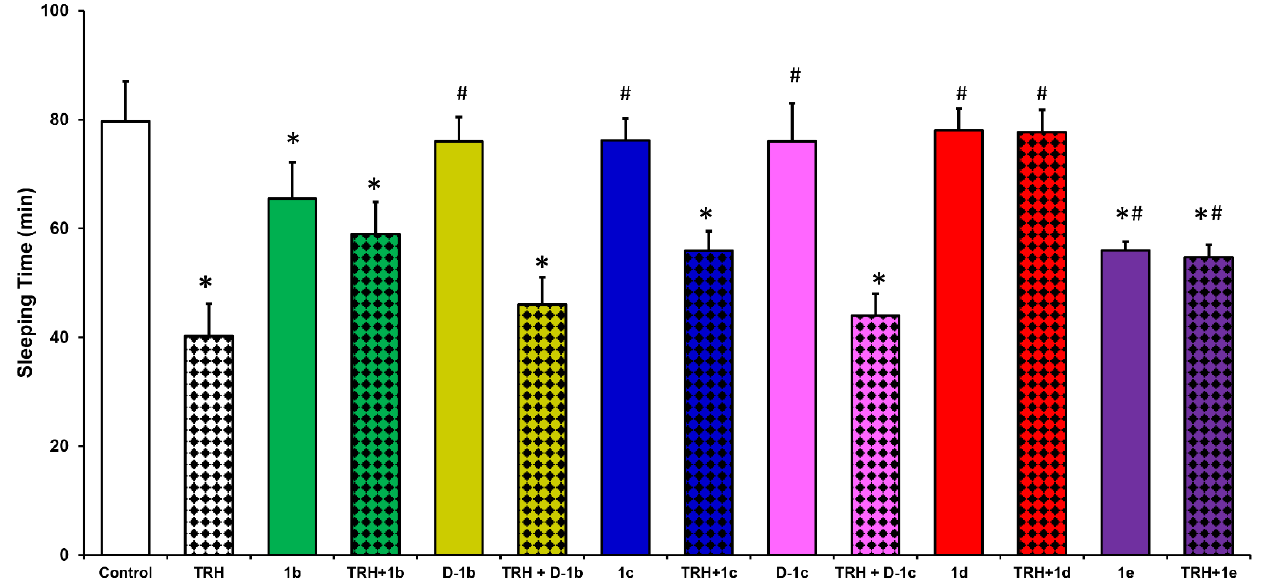
Figure 2. Reversal of pentobarbital-induced narcosis in CD-1 mice by [Glu 2 ]TRH-like peptides (Figure 1) alone or when co-administered with TRH. Ten minutes after i.v. injection of test agent alone or together with TRH (10 µmol/kg body weight, each), pentobarbital (60 mg/kg body weight, i.p.) was administered. The sleeping time was recorded from the onset of the loss of righting reflex until the reflex was regained. Data are given as mean ± standard deviation (SD). Analysis of variance (ANOVA) followed by post hoc Tukey’s tests ( p < 0.05, n = 10–14): * indicates statistically significant difference from control, # indicates statistically significant difference from TRH alone.